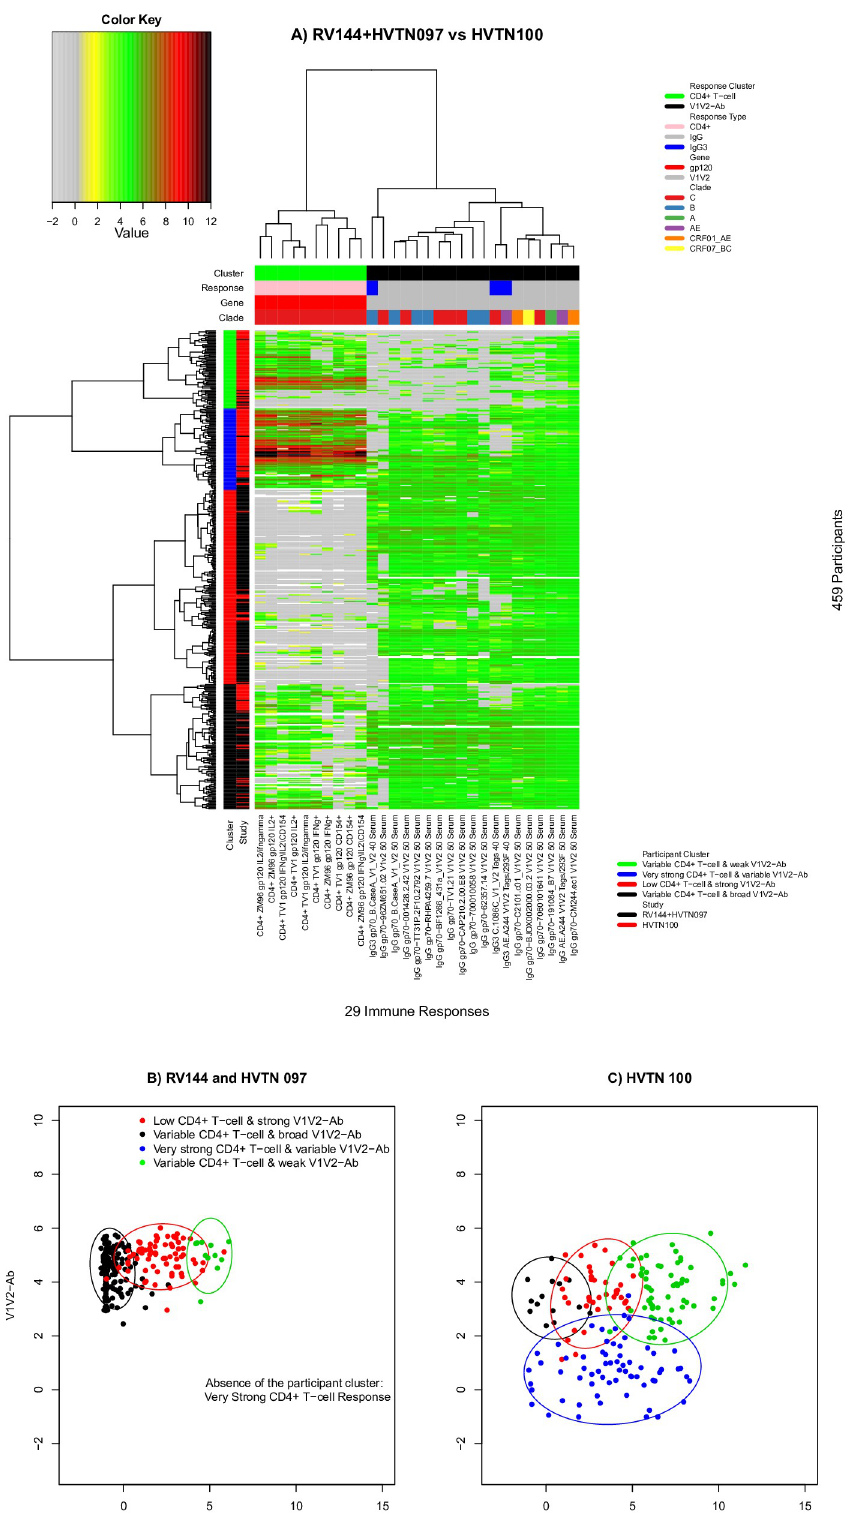
Fig 4. Immune response landscapes for the P AE/B /alum and P C /MF59 regimens. A) Heatmap of the same 29 immune response measurements combining RV144 and HVTN 097 vaccine recipients (pooled) and HVTN 100